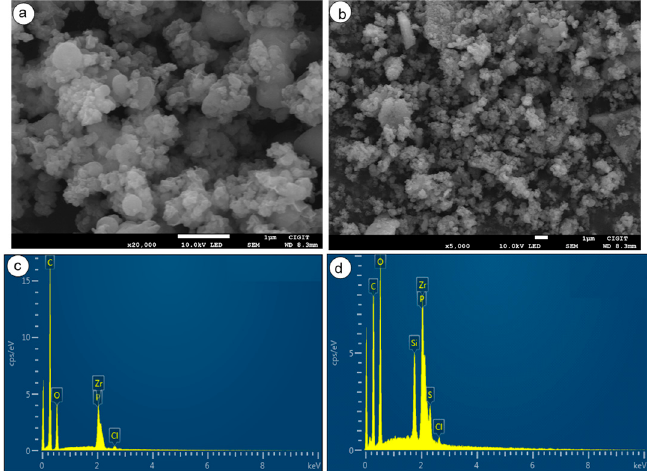
Figure 5. SEM photograph of ( a ) ZPS–PVPA, ( b ) ZPS–PVPA–SO 3 H, and the measured EDS images of ( c ) ZPS–PVPA, ( d ) ZPS–PVPA–SO 3